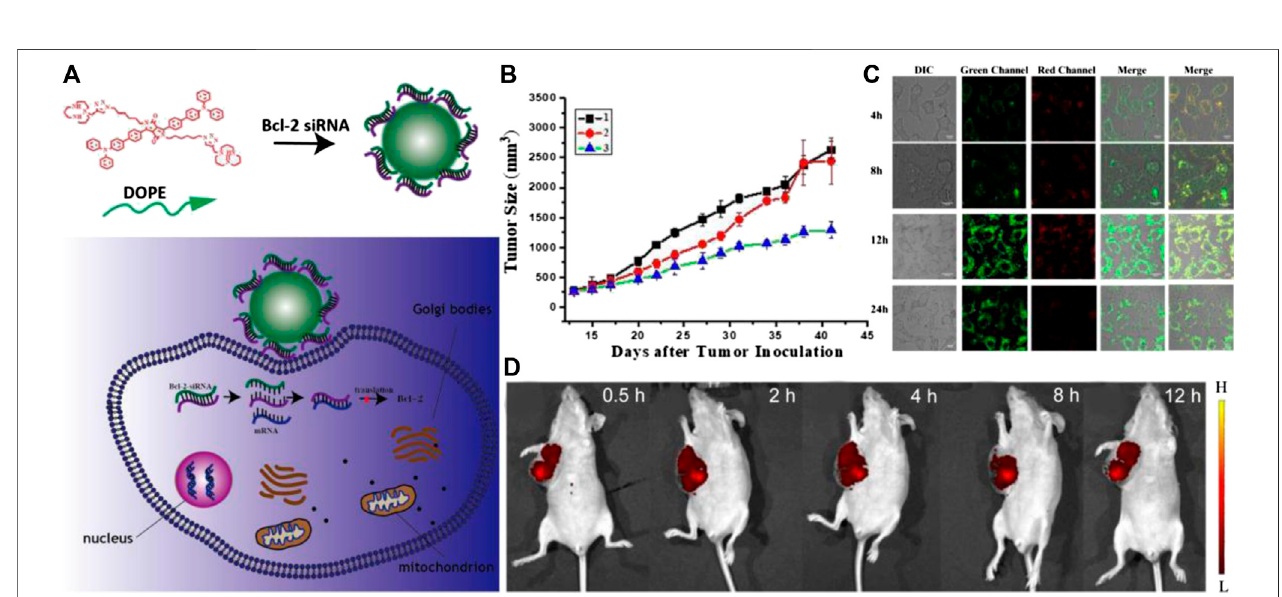
FIGURE4|(A) TheschemeoftumortargetinggenevectorsforvisualtrackingofBcl-2siRNA transfection andanti-tumor therapy. (B) Bodyweight changesofthe nude mice of different groups over 41 days; (C) Fluorescent confocal laser scanning microscopic images of Hela cells after treatment with DPL/siRNA under different incubation time. The siRNA was labeled with fl uorescein amidite (FITC). The embedded scale bars correspond to 10 μ m. (D) Fluorescence imaging of tumor-bearing mice in vivo after DPL/siRNA injection via tail vein. Reproduced with permission from Sun et al. (2020). Copyright 2020 American Chemical Society.